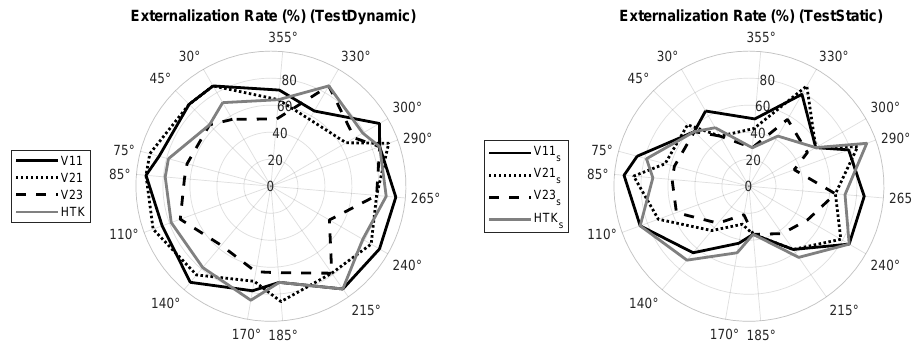
Figure 13. Externalization rate when localizing virtual sources generated with V11, V21, V23 and HTK in TestDynamic ( left ) and with V11 s , V21 s , V23 s and HTK s in TestStatic ( right ).